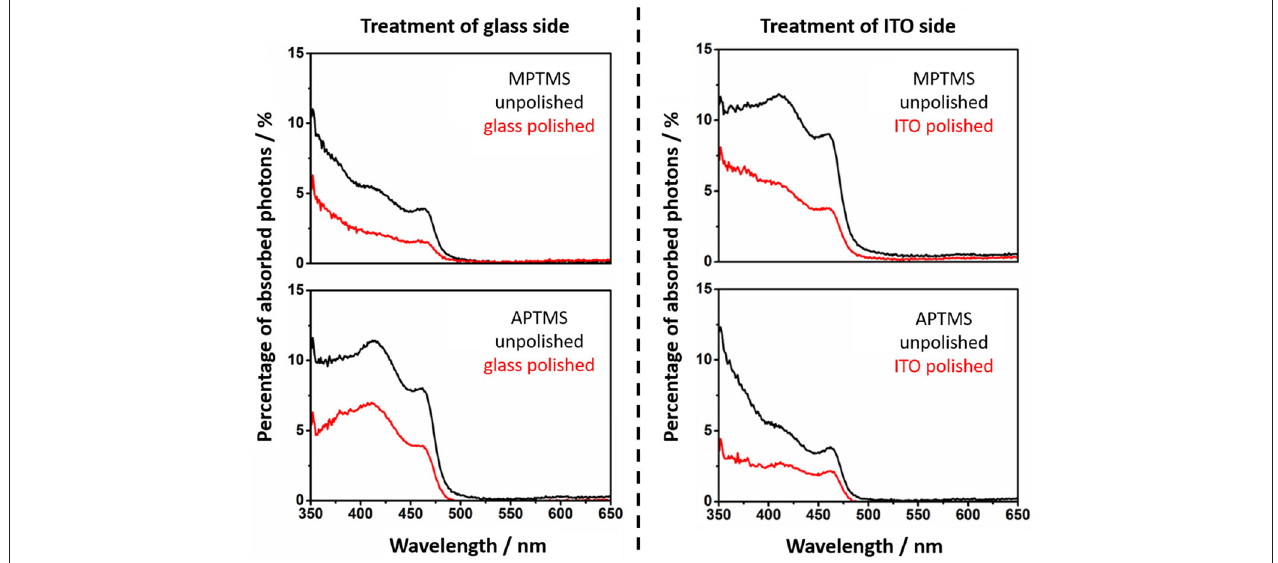
FIGURE 4 | Absorption spectra of the MPTMS and APTMS functionalized substrates with NR decoration. The spectra of unpolished slides are given in black. The absorption spectra of polished slides are red. It is always mentioned if the glass or ITO side is polished. The shape of the NR based absorption differs slightly from sample to sample since interference effects are present.